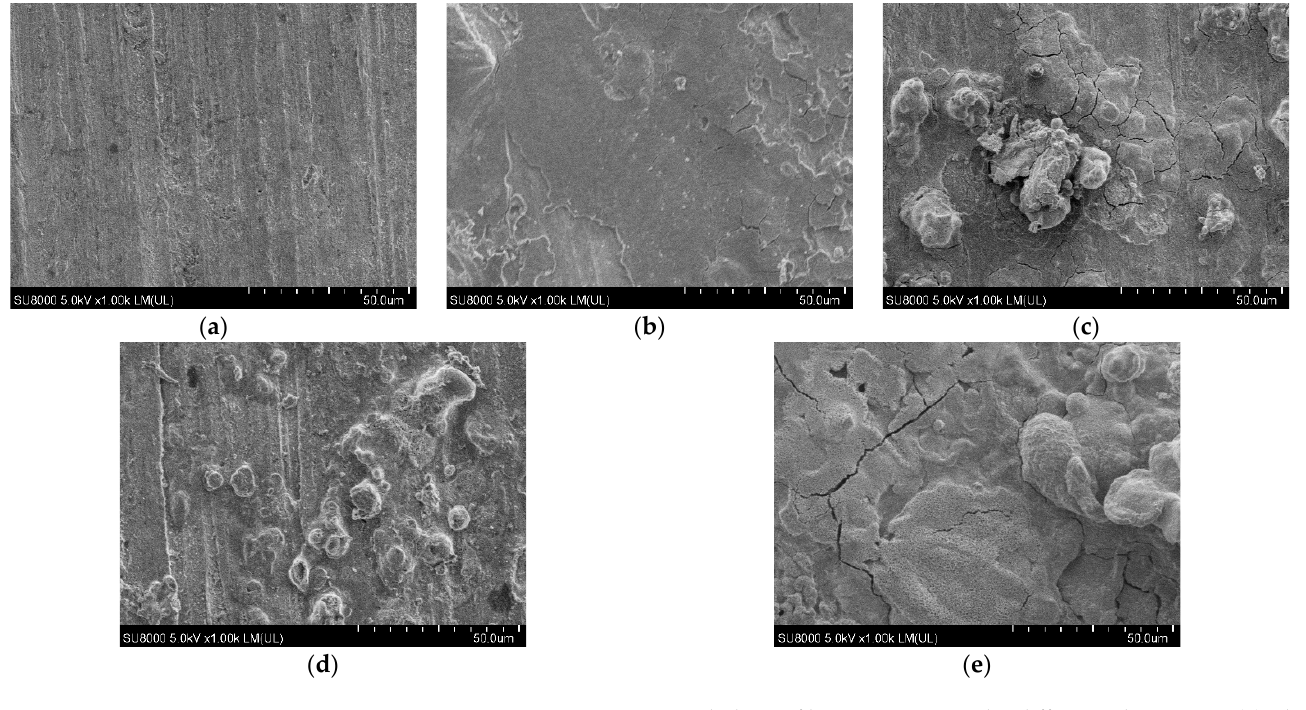
Figure 9. Variation curve of dynamic corrosion rate of 20# steel with Cl − content.